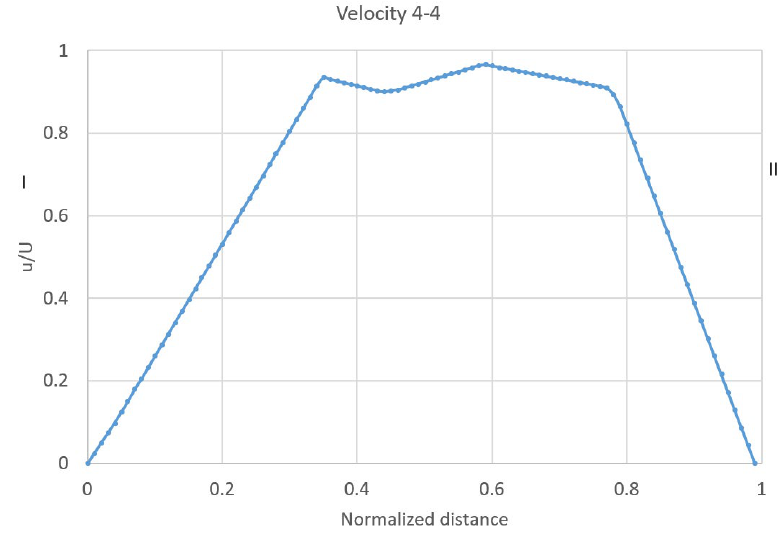
Figure 13. Velocity profile at cross-section (4-4) in the gap between containers.